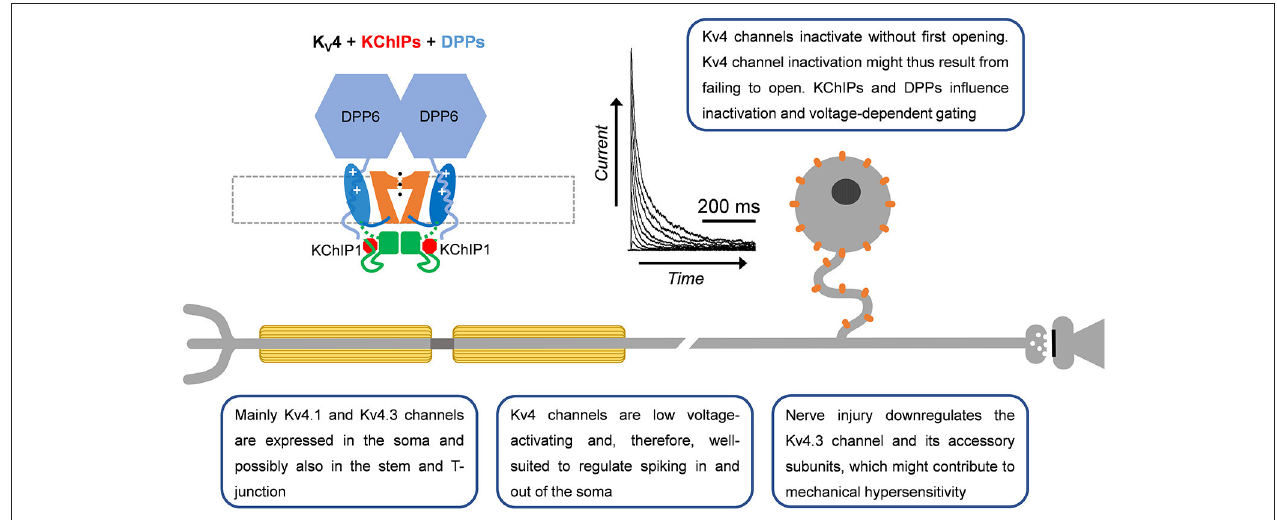
FIGURE 4 | A-type Kv4 channels in primary nociceptive neurons. Cartoon rendering of the Kv4 channel complex including the pore-forming a-subunit with its characteristic Kv channel functional domains ( Figure 2 ; VSD, PD, and T1). Two distinct accessory subunits are also part of this complex: KChIPs and DPPs. Whereas KChIPs are cytoplasmic and bind to the vestigial α NTID to prevent N-type inactivation, DPPs are single-pass membrane spanning proteins that might interact with the VSD to determine the native voltage dependence of Kv4 channels. In addition, the cytoplasmic N-terminal region of DPP6 increases unitary conductance through long-range electrostatic interactions. Kv4.3 immunoreactivity has been detected mainly in somata of small-diameter DRG neurons. Based on the ability of Kv4 channels to regulate backpropagating APs in the CNS, and their particular subcellular localization in DRG neurons, they might act as ‘shock absorbers’ to actively regulate AP propagation into and out of the